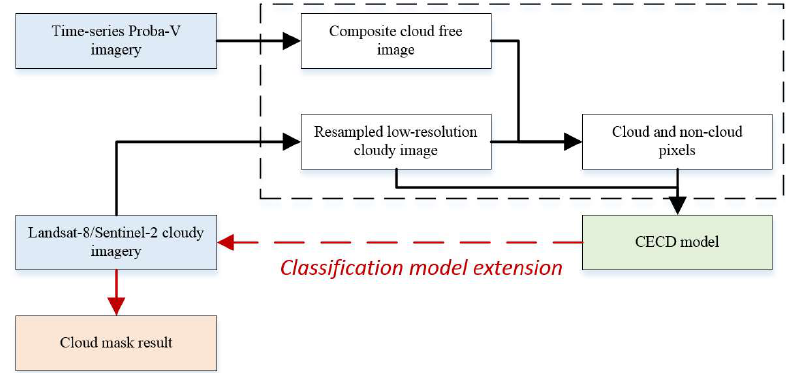
Figure 2. Flowchart of the classification extension-based cloud detection (CECD) method. The input datasets are shown in blue dotted boxes.